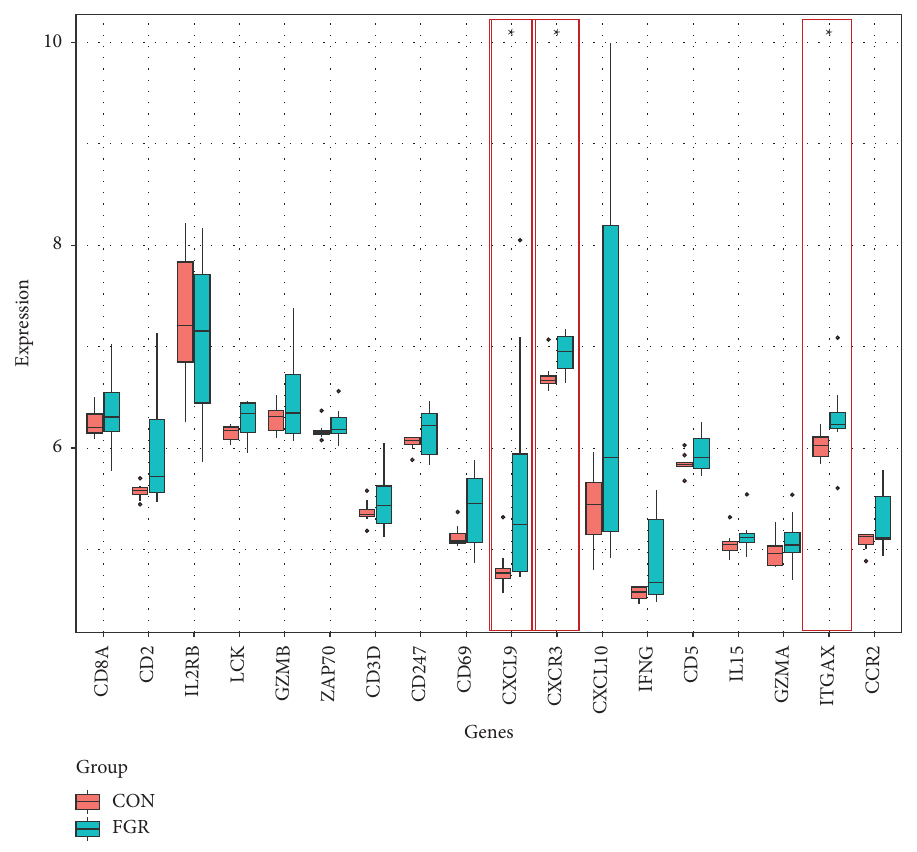
Figure 6: Validation of 20 core genes in dataset GSE24129.